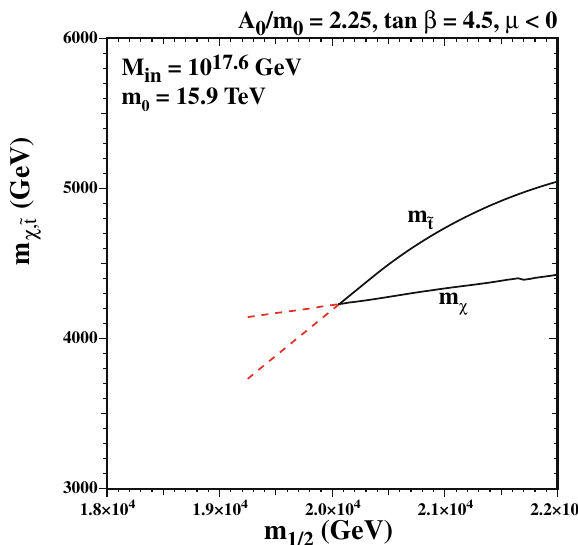
Fig. 5 The values of m χ and m ˜ t (solid black lines in the bino LSP 1 region, dashed red lines in the stop LSP region) as functions of m 1 / 2 for the parameters tan β = 4 . 5 , M in = 4 × 10 17 GeV, M (cid:5) = 3 × 10 17 GeV, λ (cid:5) = 0 . 005 and λ (cid:5) = 1, with m 0 chosen to obtain the cosmological value of (cid:21) LSP h 2 for m 1 / 2 = 20